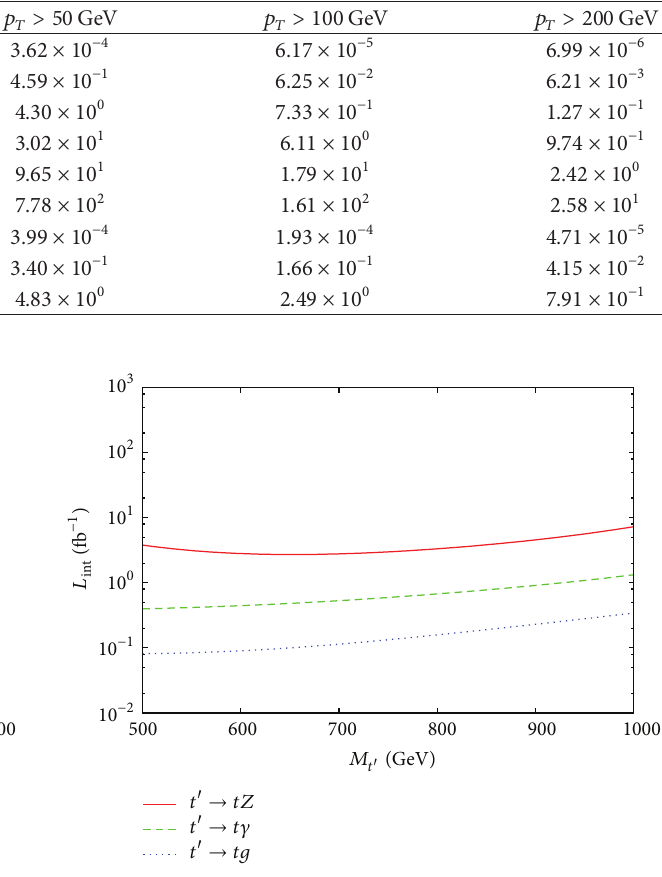
Figure 7: The same as Figure 5, but for parametrization